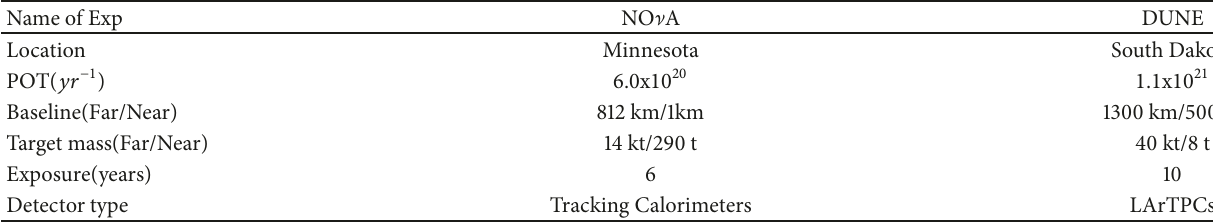
Table 1: Details of experiments.